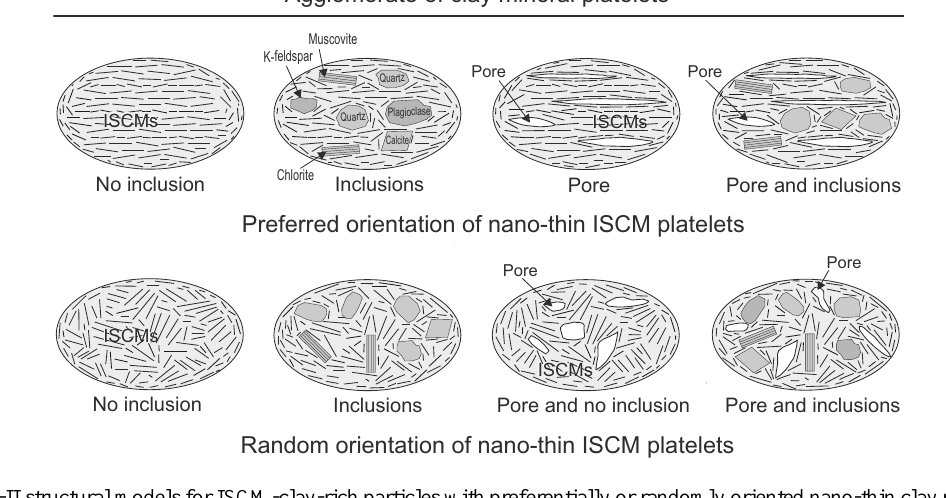
Figure 15. Type-II structural models for ISCM-clay-rich particles with preferentially or randomly oriented nano-thin clay platelets, and with pores and inclusions of nonphyllosilicates, micas (muscovite and biotite), and chlorite.